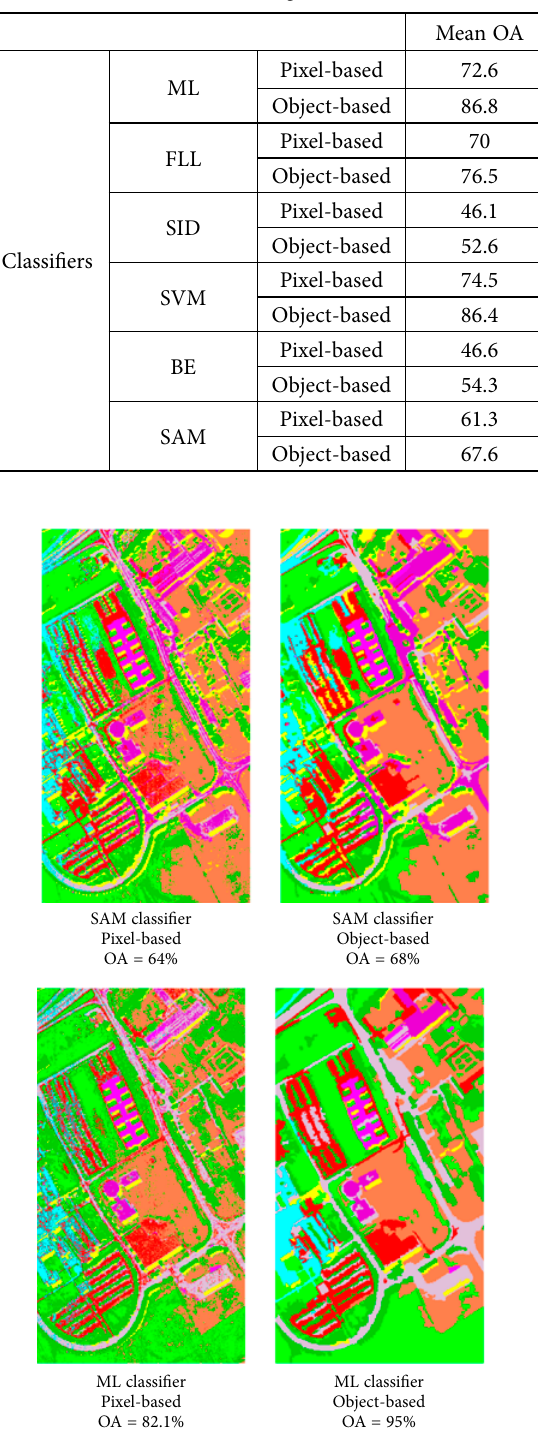
Table 4. Mean performance of classifiers with feature extraction